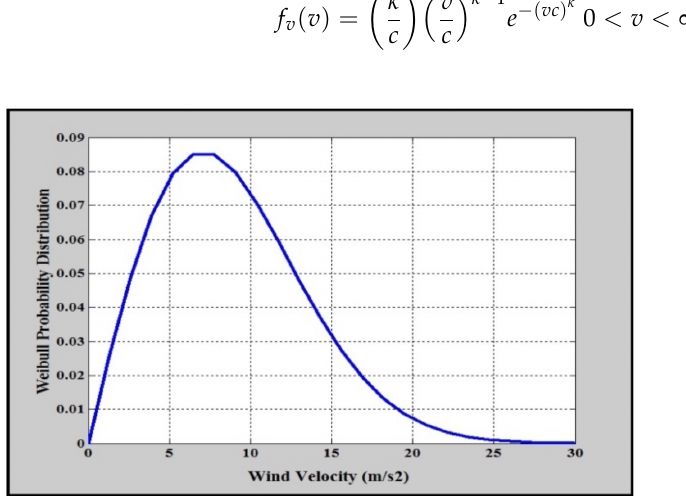
Figure 2. The Weibull probability distribution for wind